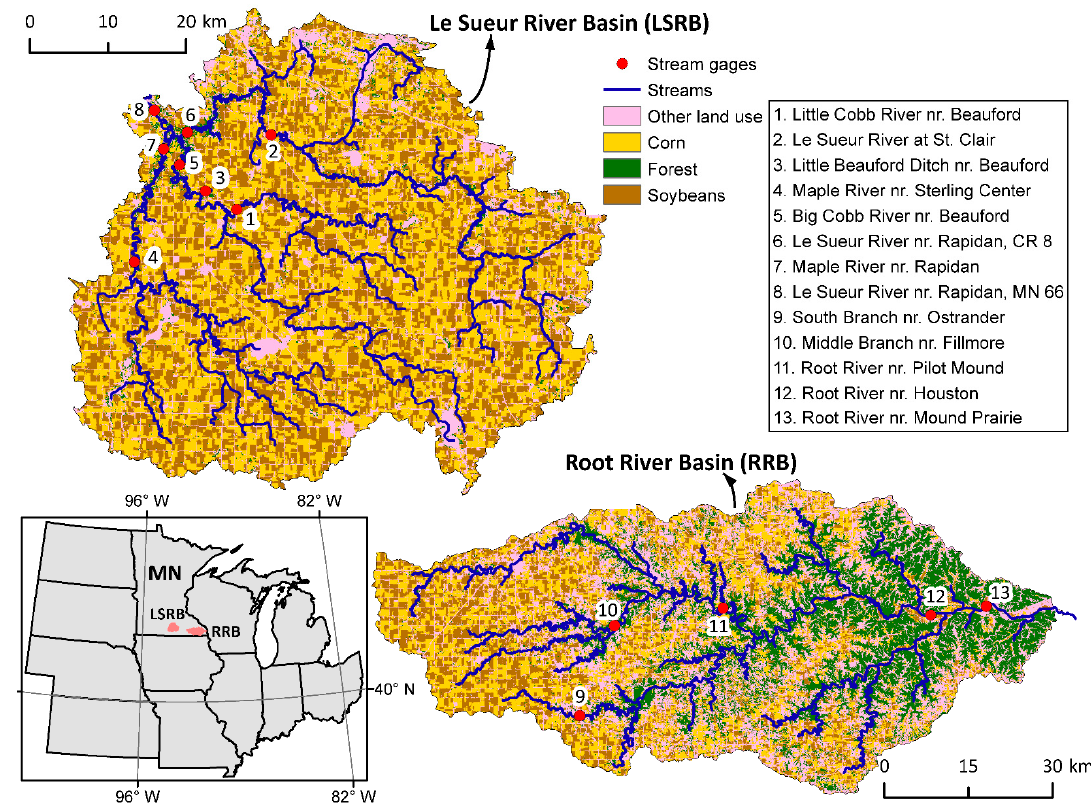
Figure 1. Map of midwestern US showing the two watersheds included in this study. Land use map of Le Sueur River Basin (LSRB) and Root River Basin (RRB) are overlaid with streamflow gages where the SWAT models were calibrated and validated. Land use from the year 2006 is shown for the two basins. Corn, soybean, forest (deciduous, evergreen and mixed forests) and all else (e.g., grass/pasture, develop/open space and others) are combined as other land use.